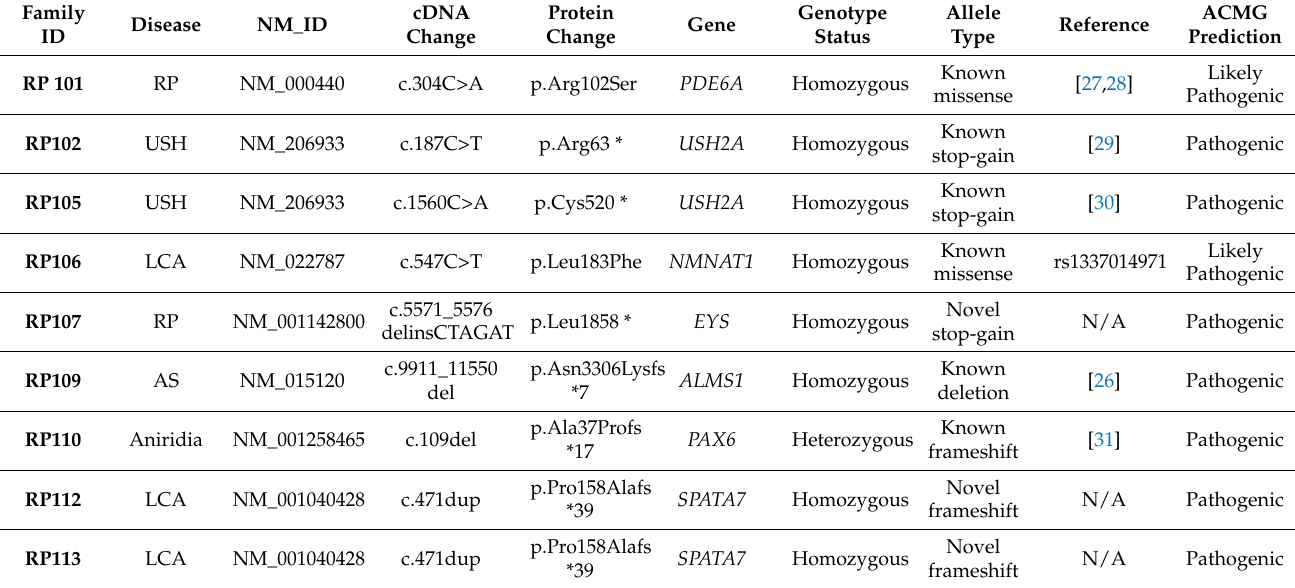
Table 2. List of previously reported and novel pathogenic variants identified in nine unrelated